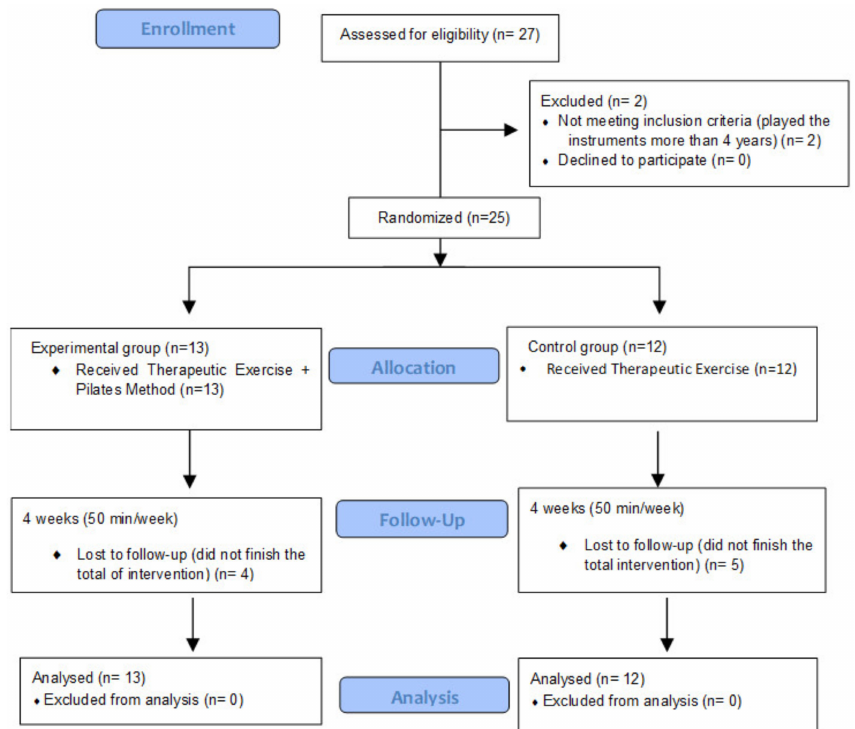
Figure 7. Consort flow diagram of progress through the phases of the randomized clinical trial of the therapeutic exercise–Pilates method and therapeutic exercise groups (enrollment, allocation, intervention, follow-up, and analysis of the